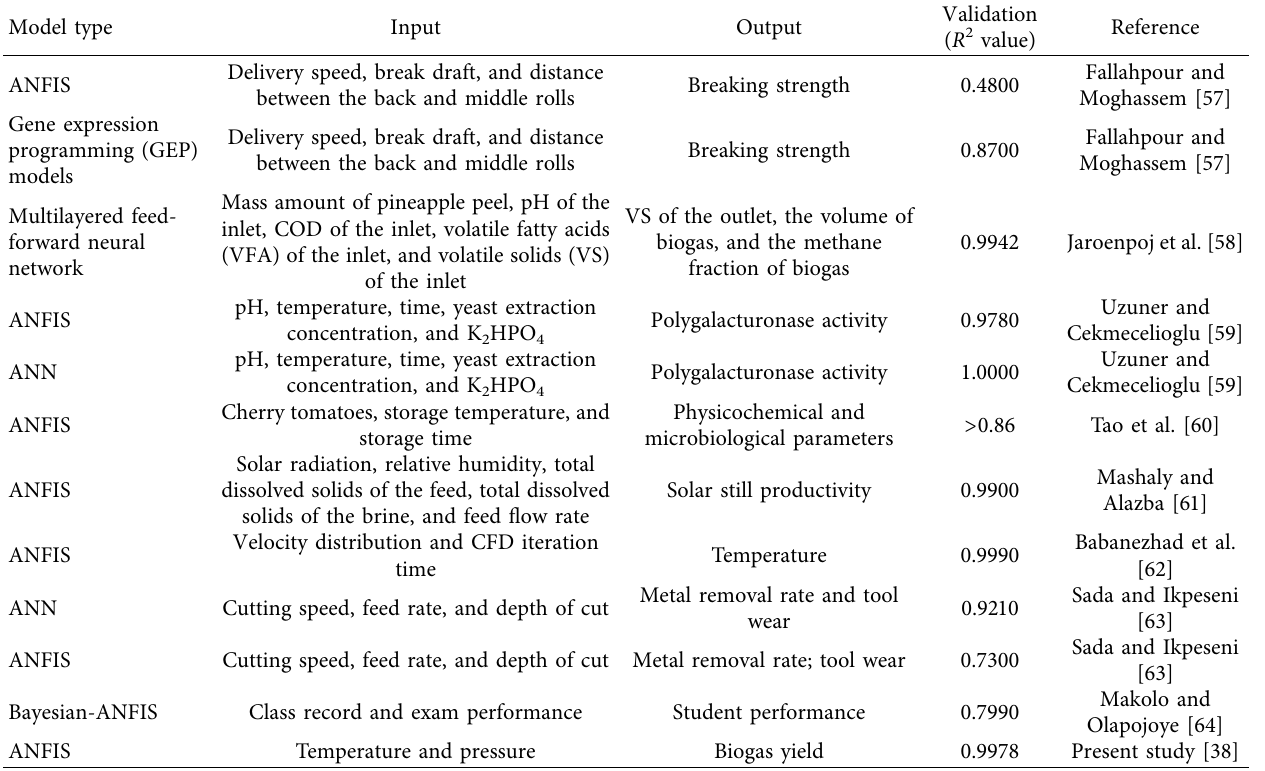
Figure 8: Efectiveness of the ANFIS prediction (qualitative plot). Table 7: Comparison of developed ANFIS and previous models found in the